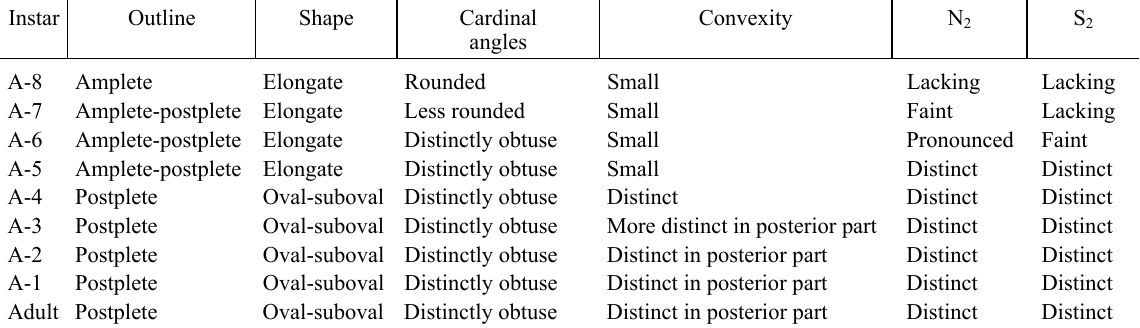
Table 3. Development of valve characters during the Conchoprimitia osekensis (P ř ibyl, 1979)